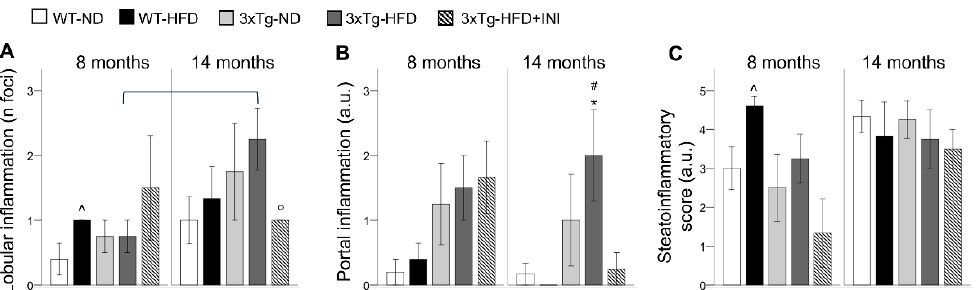
Figure 3. Liver lobular ( A ), and portal inflammation ( B ), and the cumulative steato-inflammatory score ( C ) are shown for each group. Mean ± SEM shown. Different symbols are used for each within-age comparison, * vs. WT, ˆ vs. ND, # vs. WT-ND, ◦ vs. 3xTg-HFD. A line is used to identify statistically significant differences in between ‐ age comparisons.